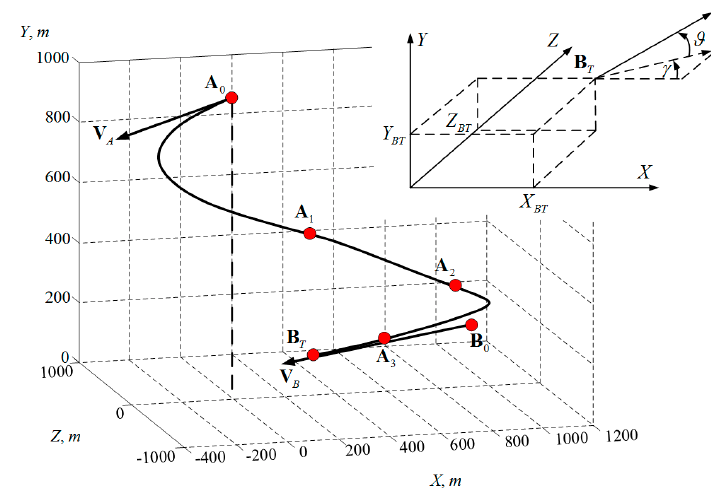
Figure 1. Approach trajectory between an UAV and a vessel.